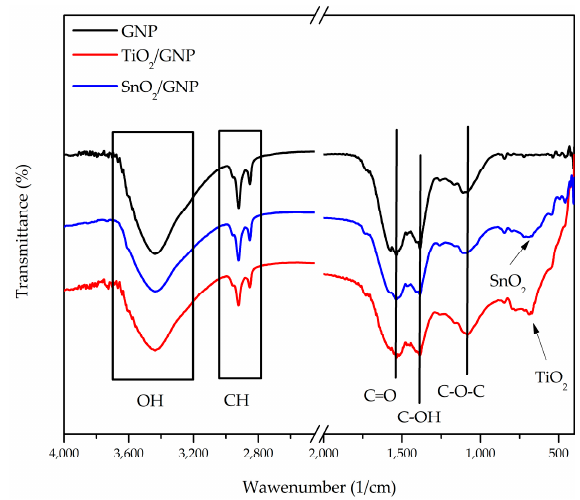
Figure 1. FTIR spectra of GNP, SnO 2 /GNP, and TiO 2 /GNP.